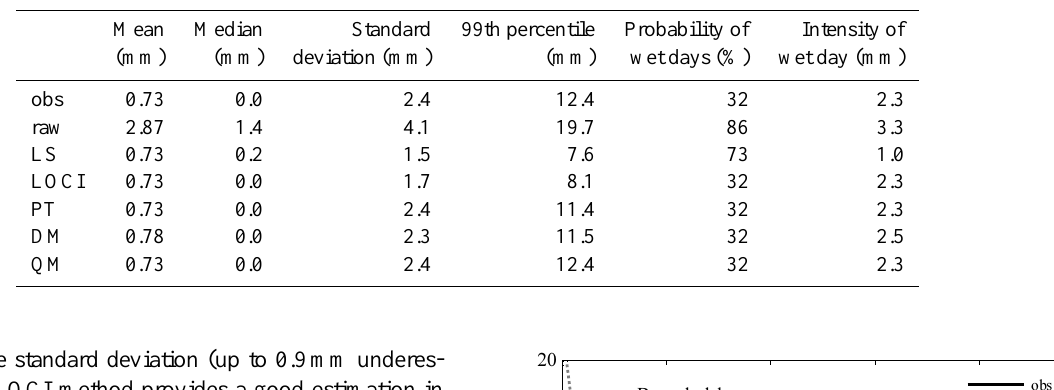
Table 4. Frequency-based statistics of daily observed (obs), raw RCM-simulated (raw) and bias-corrected precipitations at the Bayanbulak Station.